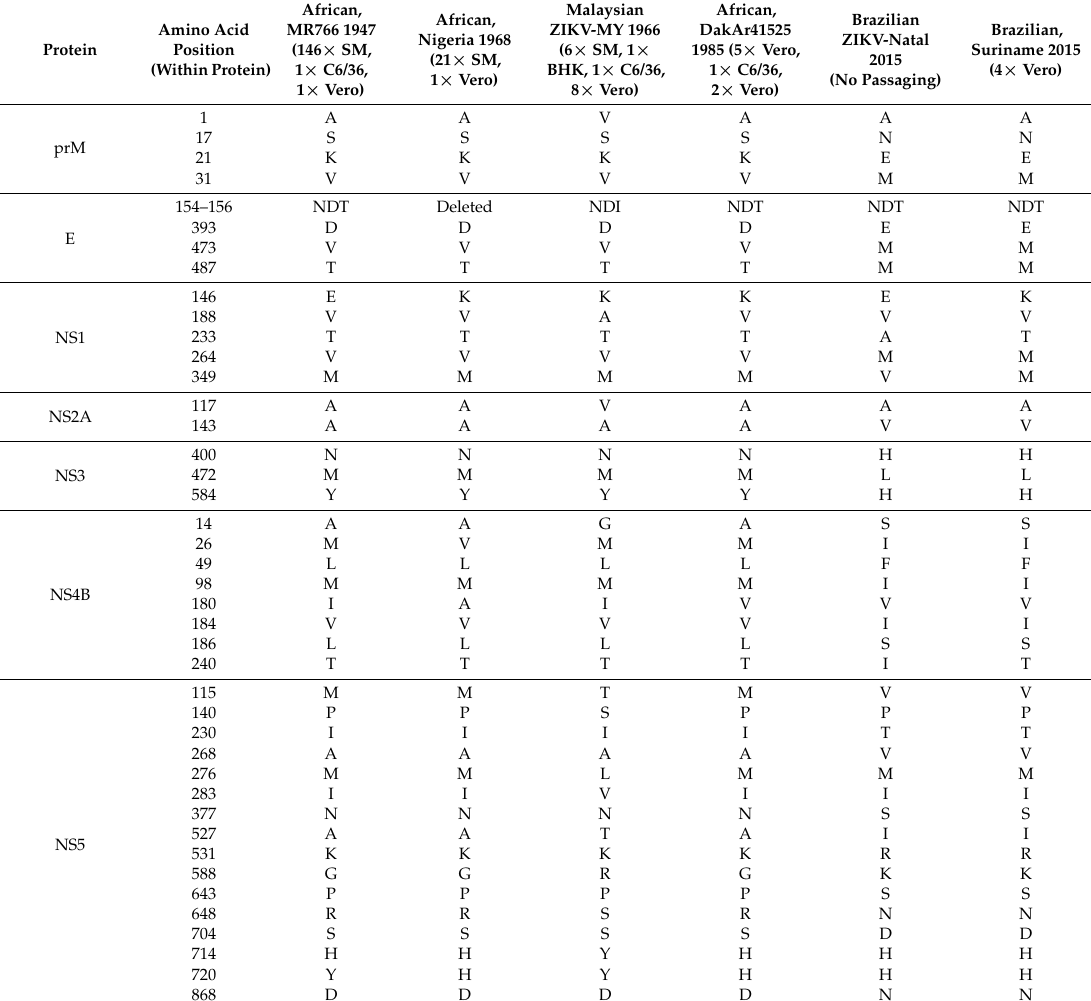
Table 2. Amino acid differences between ZIKV-MY and